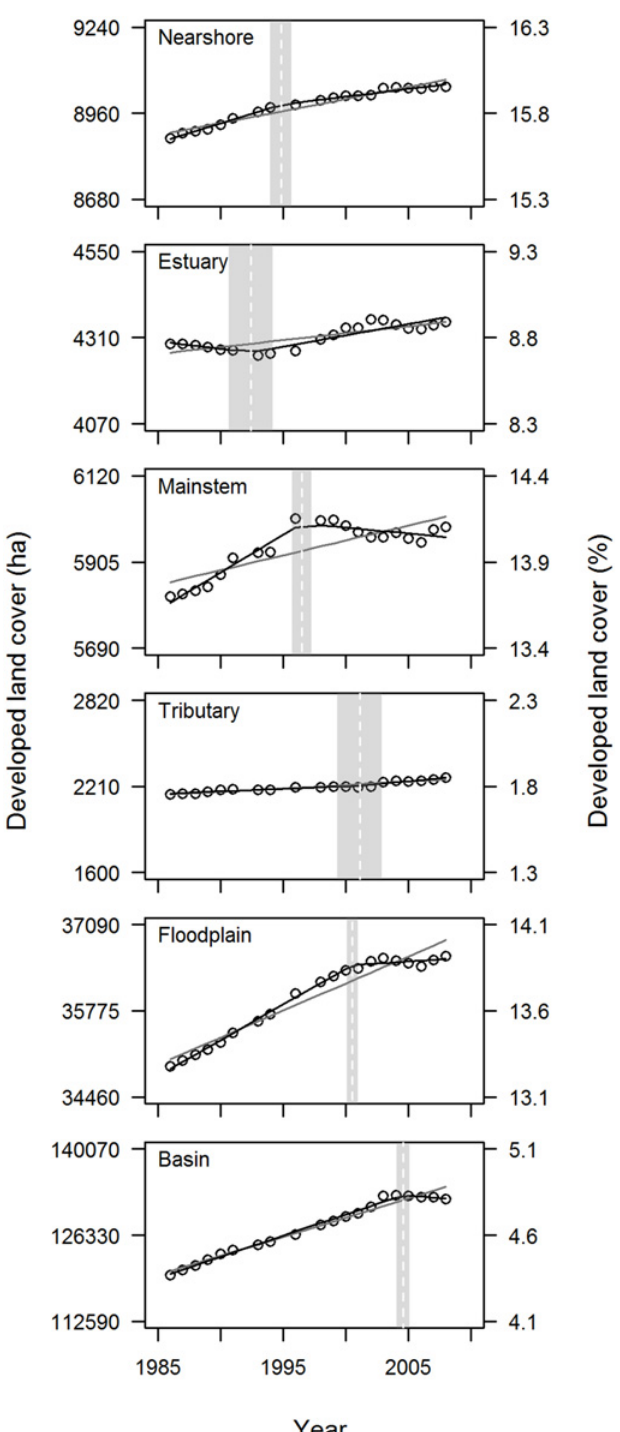
Fig 2. Trends in Developed Land Cover: Puget Sound Scale. Change over time in developed land cover, summarized at the Puget Sound scale for six habitat areas. Developed cover is depicted in ha (left axis) and % (right axis), and two types of regression models are fit to the data: simple (gray line) and segmented (black line). For the segmented model, the breakpoint estimate and standard error are also shown (dotted white line and gray rectangle,